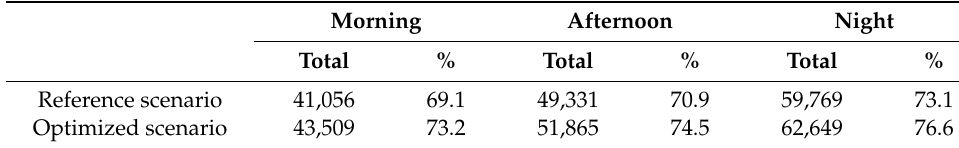
Table 7. Demand covered by parking spaces in each of the time bands by model.